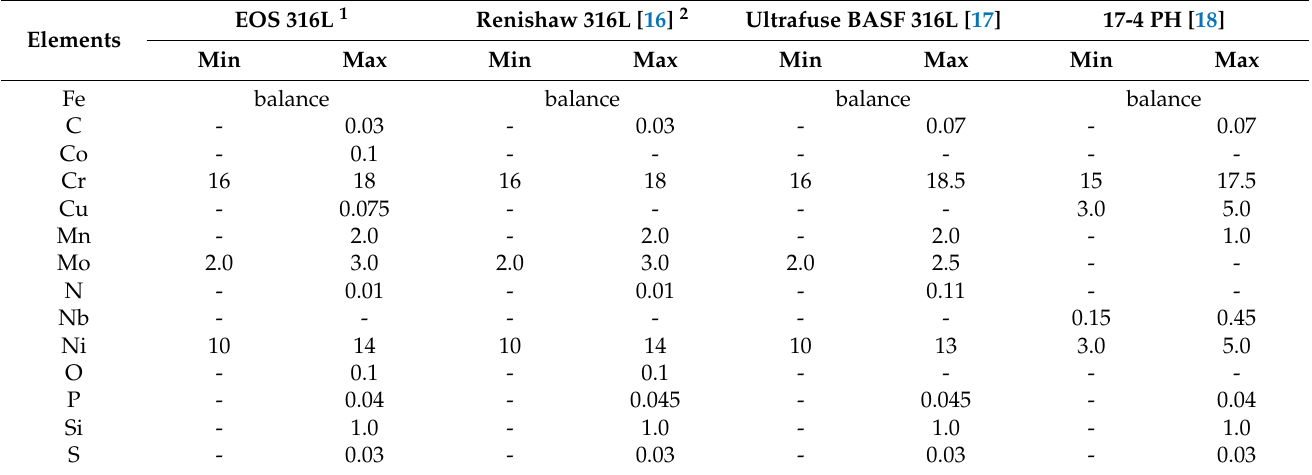
Table 1. Chemical composition of printed materials, (weight) wt %.